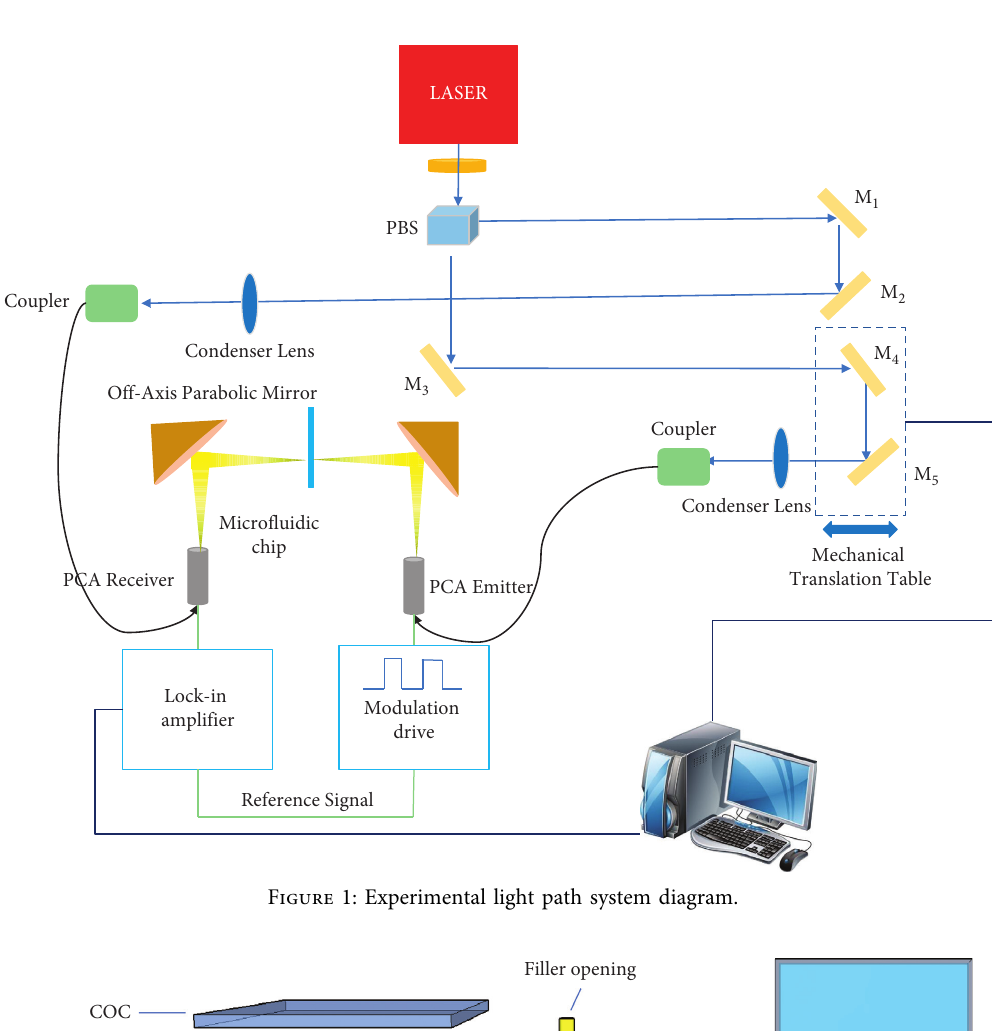
Figure 1: Experimental light path system diagram.